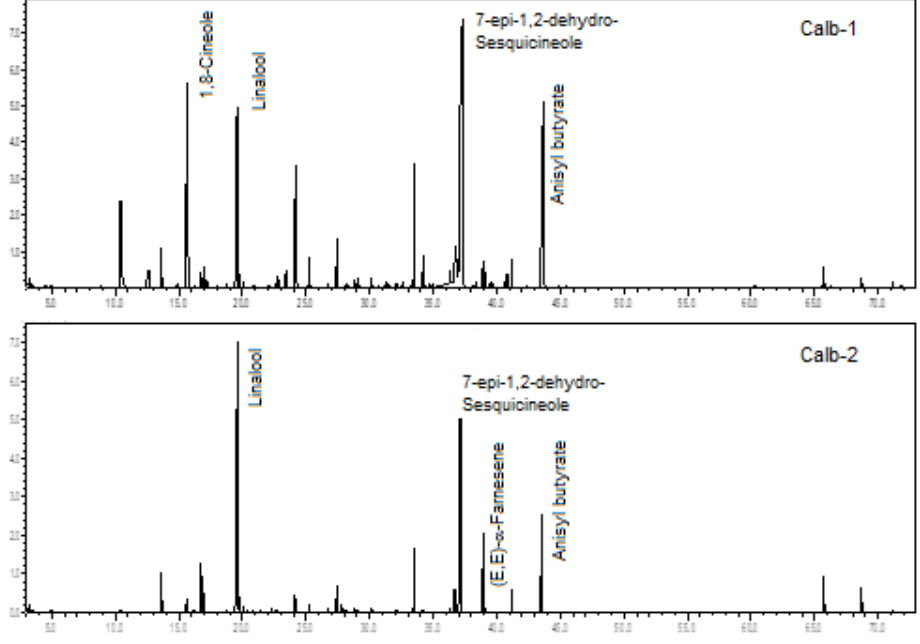
Figure 4. Ion-chromatogram of the Catasetum albovirens volatile concentrates.